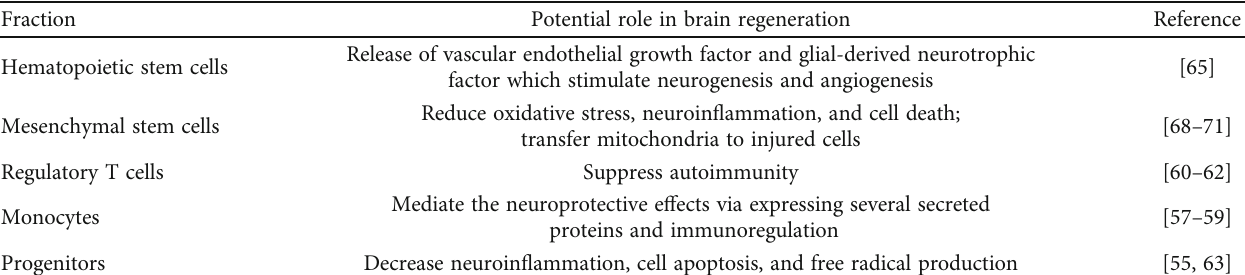
Table 1: Cord blood elements that may contribute to